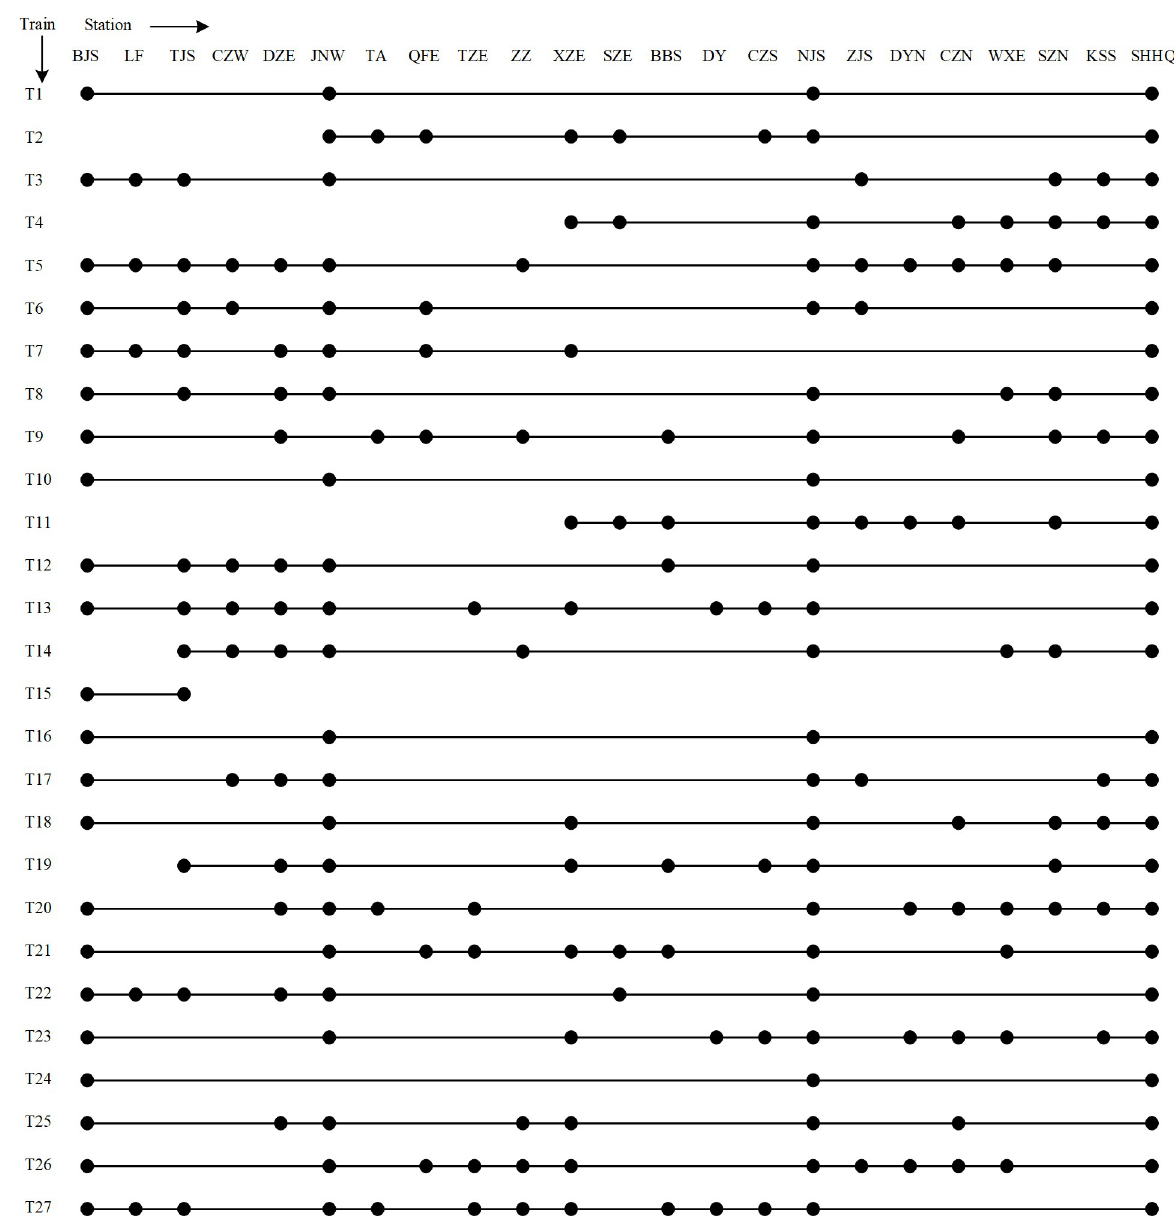
Fig 7. Optimized train stop plan of Beijing–Shanghai high-speed railway. https://doi.org/10.1371/journal.pone.0284747.g007 result is obtained after 3600 s and the gap is 0.44%. Fig 9 shows the results of the test, where the different colored lines indicate different types of trains.